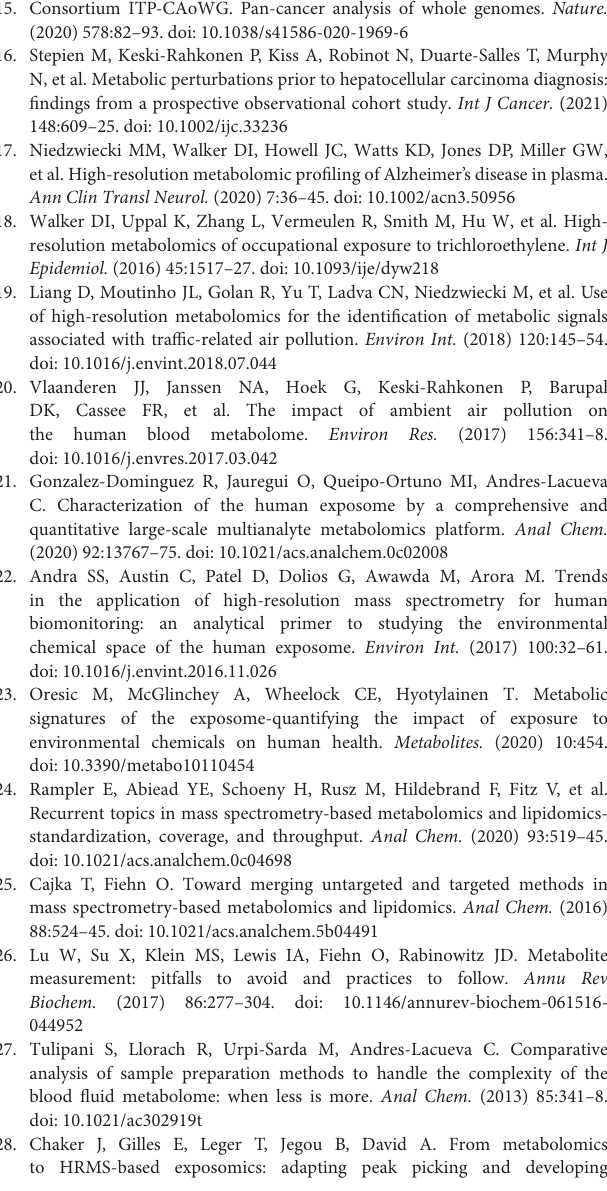
Supplementary Figure 3 | Demonstration of a negligible drift in retention time for the peak of PC 32:0 (m/z 734.57). Supplementary Figure 4 | Demonstration of a negligible drift in retention time for the peak of tryptophan (m/z 205.0976). Supplementary Figure 5 | Demonstration of a negligible drift in retention time for the peak of AC 16:1 (m/z 398.3264). Supplementary Table 1 | MS-DIAL parameters that were used for processing the LCMS data files. Supplementary Table 2 | Correlation between birth weight and LC/MS peaks as computed by the spearman correlation